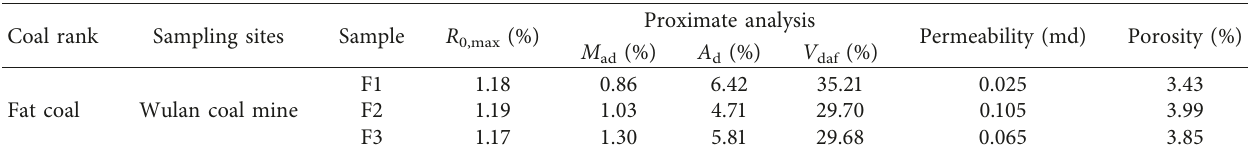
Figure 2: Microphotometer and polished lump coal section: (a) NIS-Elements Documentation optical microscope; (b) polished block. Table 1: Coal sample and basic properties.